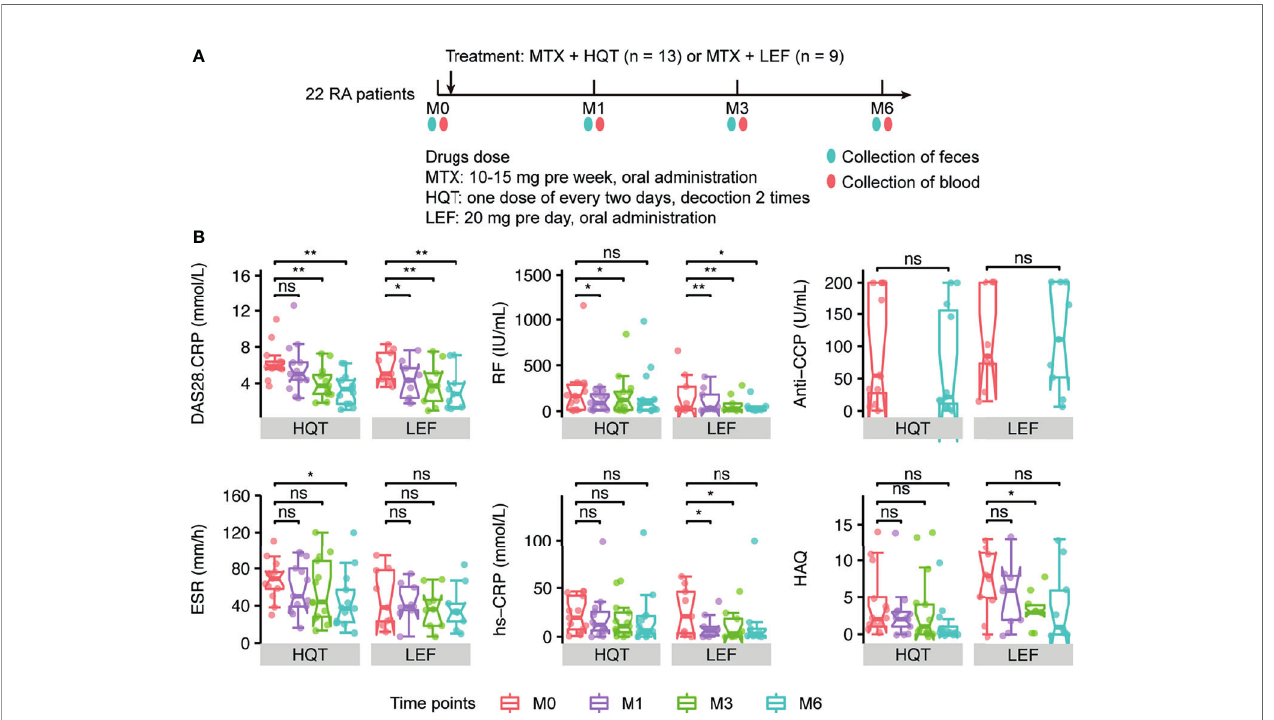
FIGURE 3 | Different effects of the two treatments on primary clinical indicators (A) Sample collection time points in the two treatment groups. (B) Changes between time points in RA-related primary clinical indices in HQT and LEF groups. *P < 0.05; **P < 0.01, ns, no signi fi cance, between different time points according to Wilcoxon rank-sum test. DAS28-CRP, disease activity score for 28 joints based on the C-reactive protein level; RF, rheumatoid factor; Anti-CCP, anti-cyclic citrullinated peptides; CRP, high-sensitivity C-reactive protein; ESR, erythrocyte sedimentation rate; HAQ, health assessment